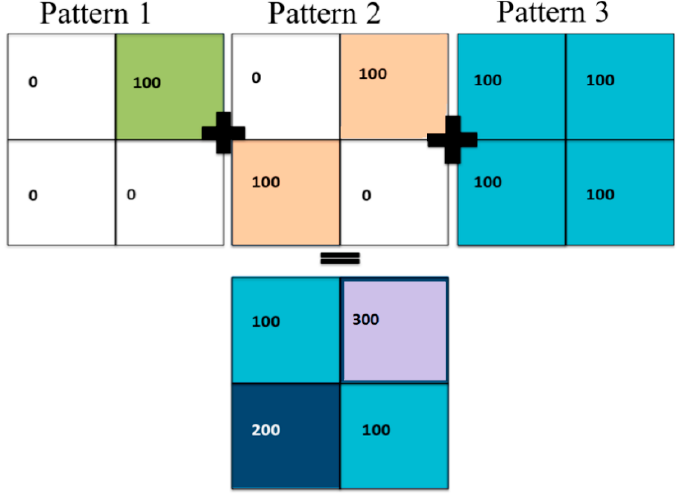
Figure 2. Potential ecological distribution of a species in 4 pixels according to 3 variables (patterns).